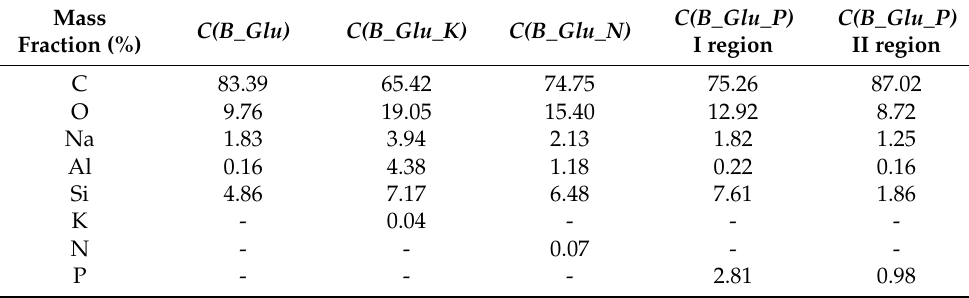
Table 5. EDS composition of the obtained carbons.